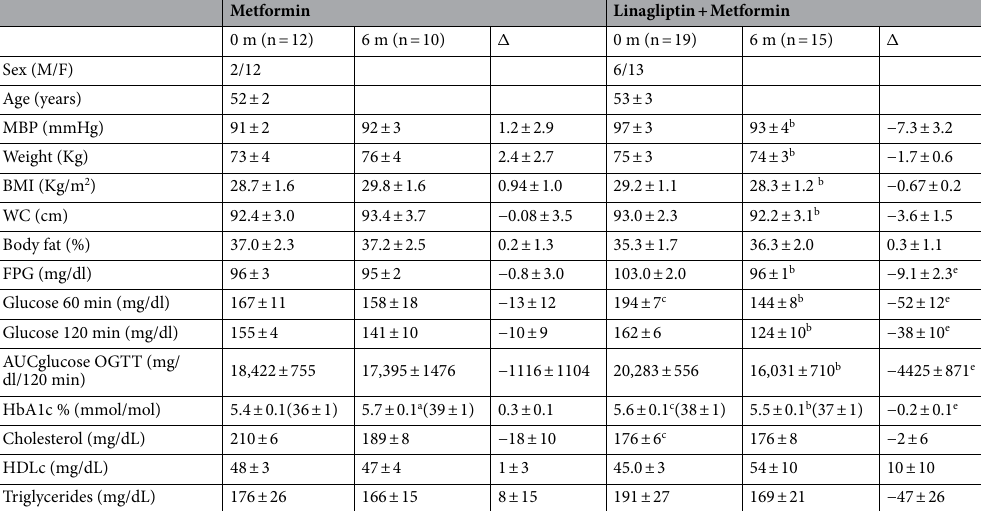
Table 1. Clinical and anthropometric characteristics at the beginning and at the end of the study, in the treatment groups. Data are Means ± SE. (cid:31) = change from baseline, MBP Mean Blood Pressure, BMI body mass index, WC waist circumference. OGTT oral glucose tolerance test, AUC area under the curve, HbA1c: glycated hemoglobin A1c, HDL high-density lipoprotein cholesterol. a = p < 0.05 Metformin intragroup. b = p < 0.05 Linagliptin + Metformin intragroup. c = p < 0.05 intergroup at the beginning of the study (0 months). d = p < 0.05 intergroup at the end of the study (6 months). e = p < 0.05 Delta intergroup at 6 months of study.